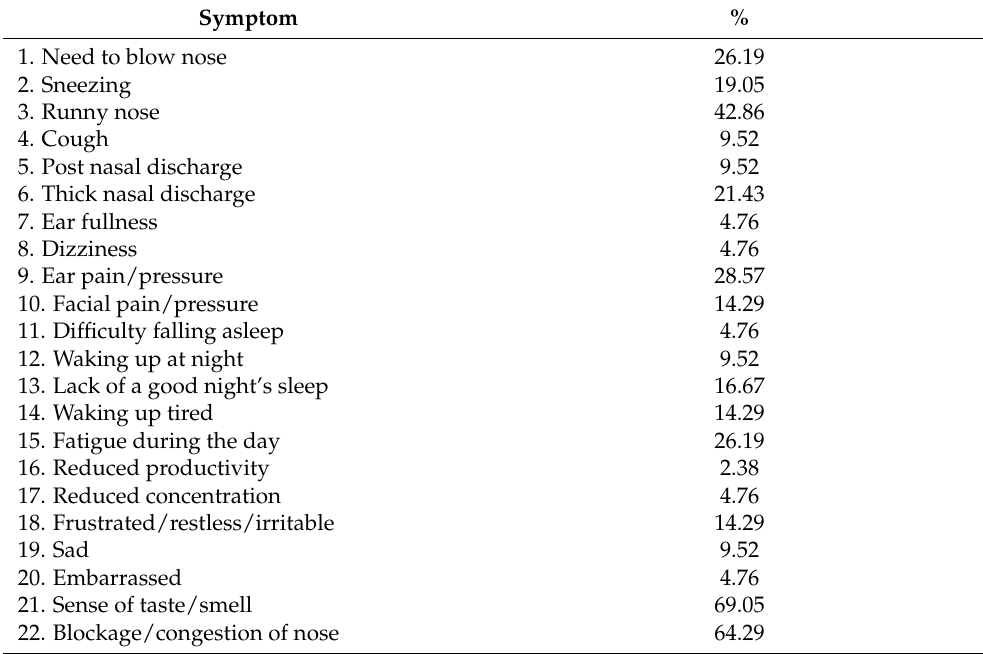
Table 1. Percentage of patients who highlighted these items of the questionnaire as being one of the 5 worst symptoms.